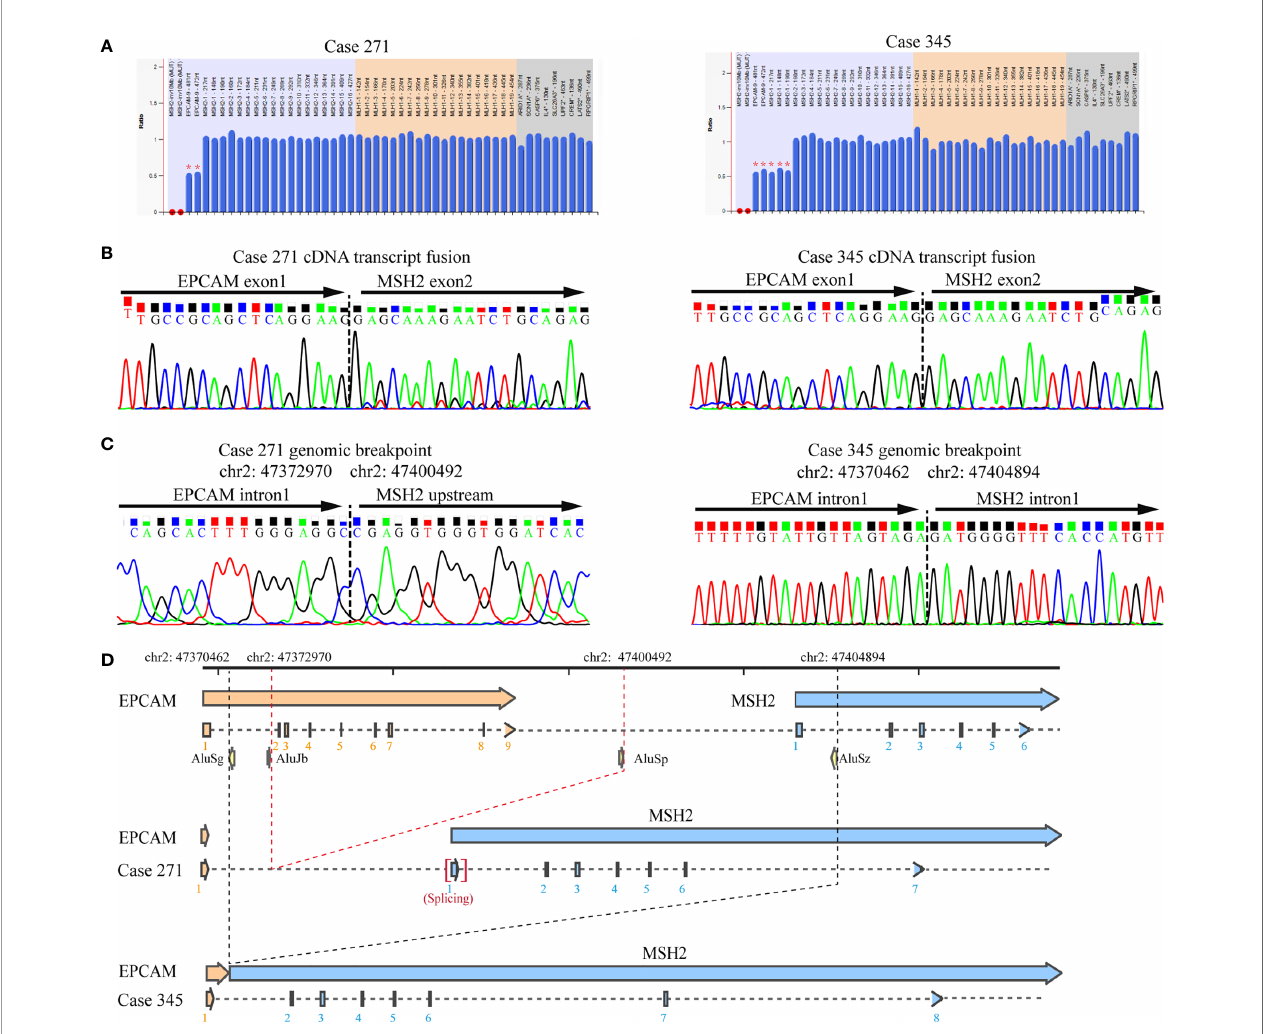
FIGURE 3 | Identi fi cation of the germline EPCAM-MSH2 fusion in patients with suspected LS and cytoplasmic MSH2 staining. (A) MLPA testing identi fi ed the presence of a large genomic deletion in the MSH2 and EPCAM genes in patients 271 and 345. (B) Sanger sequencing of EPCAM and MSH2 transcripts ampli fi ed by the E1M23-1F and E1M23-2R primer pairs in the peripheral blood cDNA of the proband revealed a fusion between exon 1 of EPCAM and exon 2 of MSH2 . (C) Sequencing analysis of long-range PCR products from genomic DNA de fi ned the exact breakpoint, as indicated by the genomic locus. (D) Schematic representation showing the genomic deletions mediated by recombination between Alu